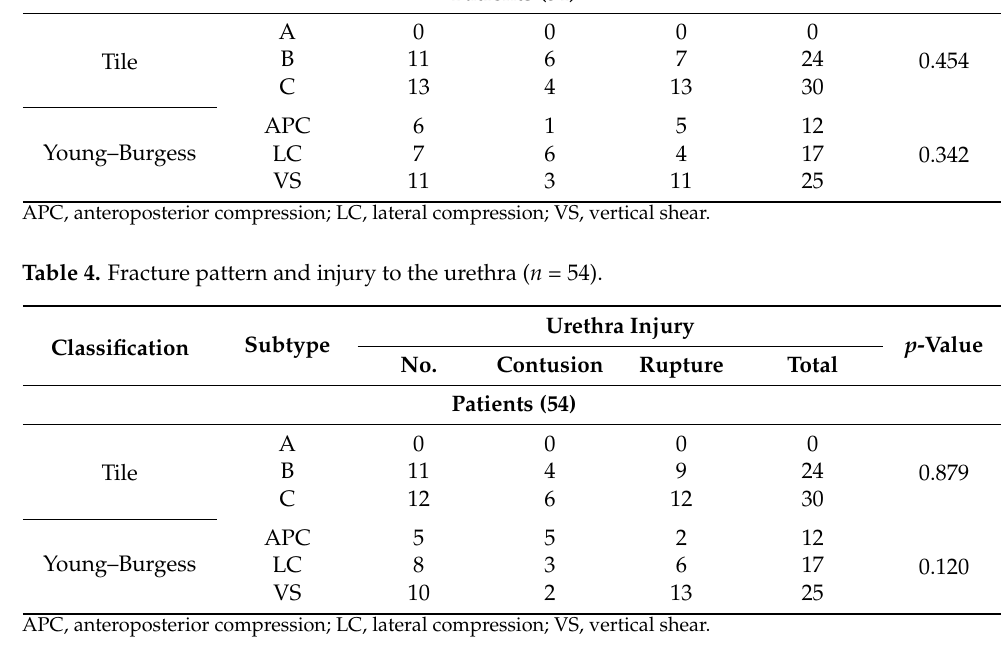
Table 5. Fracture pattern and injury to the male and female bladder ( n =